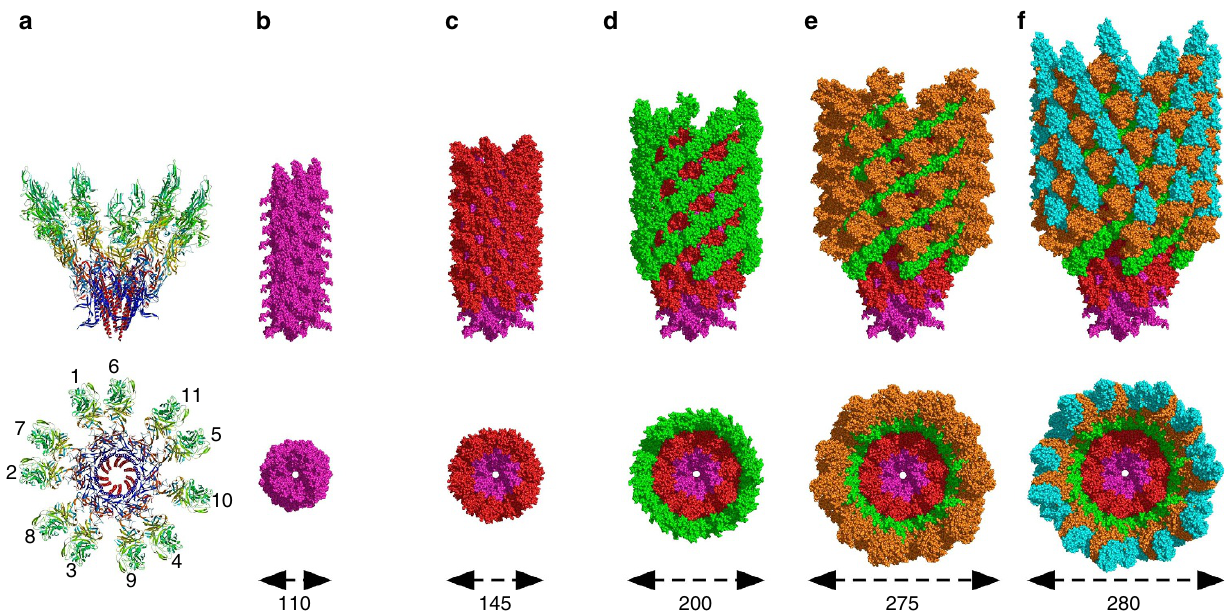
Figure 2 | Domain distribution in the hook of C. jejuni . ( a ) Lateral and top views of two turns of the hook of C. jejuni showing the eleven molecules that mark the start of the eleven protofilaments of the hook. ( b – f ) Lateral and top views of the hook of C. jejuni showing the organization and the packing of the different layers made by the domains of FlgE. Domain D0 in purple, domain D1 in red, domain D2 in green, domain D3 in brown and domain D4 in cyan. The image at left shows only D0. Additional domains are added in each subsequent image. The approximate diameters are indicated at the bottom. Figures were prepared with PyMOL (The PyMOL Molecular Graphic System, Schro¨dinger, LLC.